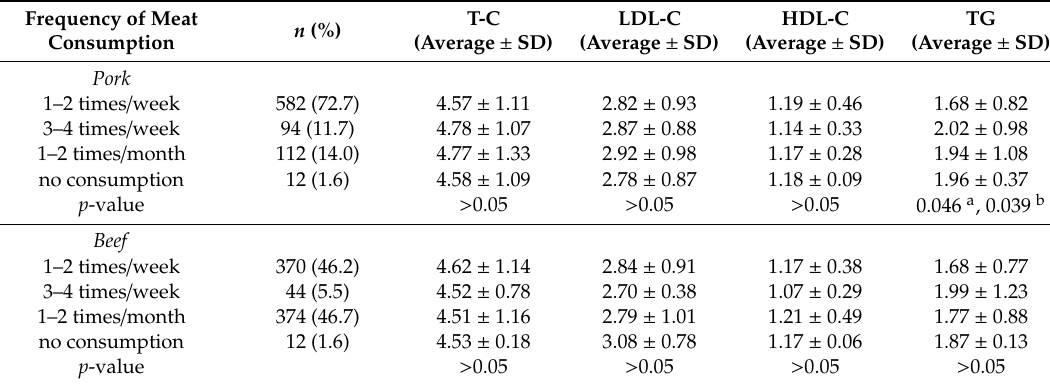
Table 4. E ff ect of the frequency of consumption of red meat on lipid profile (mmol / L).